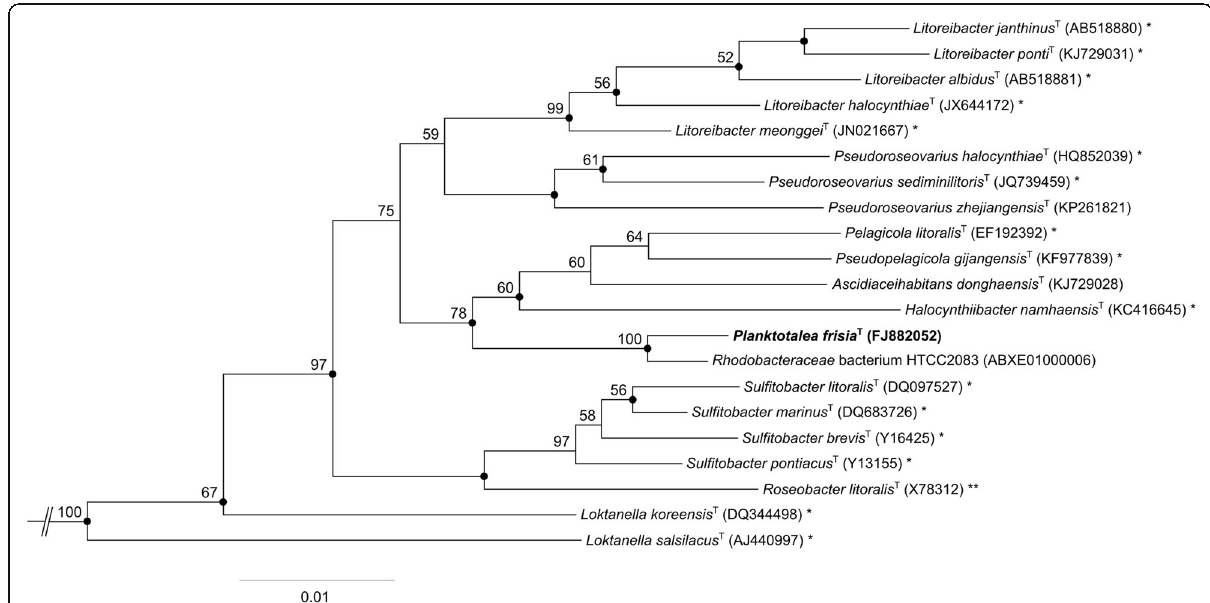
Fig. 1 Phylogenetic tree highlighting the position of Planktotalea frisia strain SH6-1 T relative to other genome sequenced and type strains within the Rhodobacteraceae . The phylogeny was constructed with nearly full-length 16S rRNA gene sequences (> 1300 bp) using the neighbor joining tool of the ARB software [15]. The calculation of the tree also involves a bootstrapping process repeated 1000 times. Only bootstrap values ≥ 50% are shown. Filled circles indicate nodes also recovered reproducibly with maximum-likelihood (RAxML) calculation. Lineages with type strain genome sequencing projects registered in GOLD [16] are labeled with one asterisk, those listed as ‘ Complete and Published ’ with two asterisks [52]. Two sequences of Staniera cyanoshaera (AB039008, AF132931) were used as outgroup (not